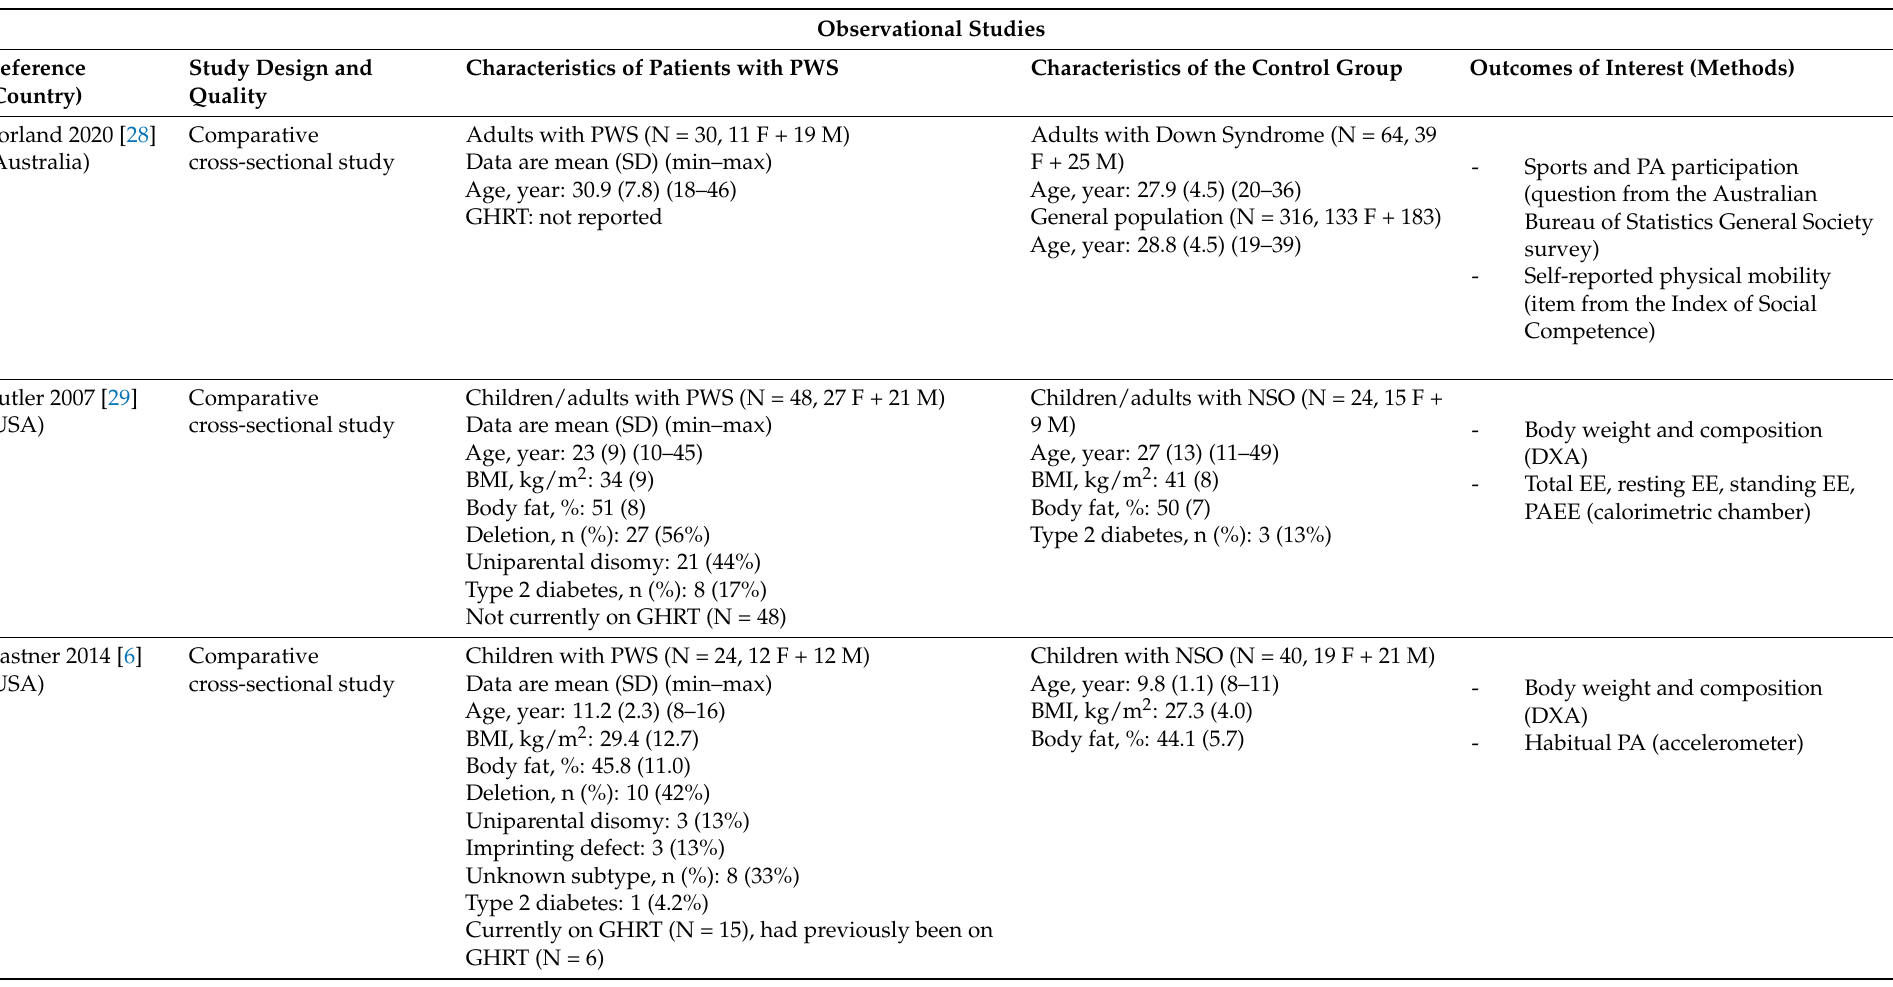
Table 1. Study characteristics (N = 25